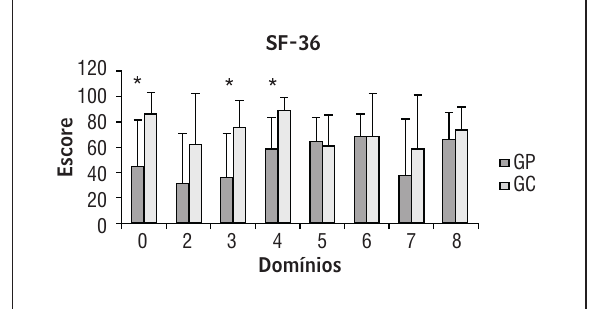
Figura 1 - Qualidade de vida de sujeitos GP (n = 8) e GC